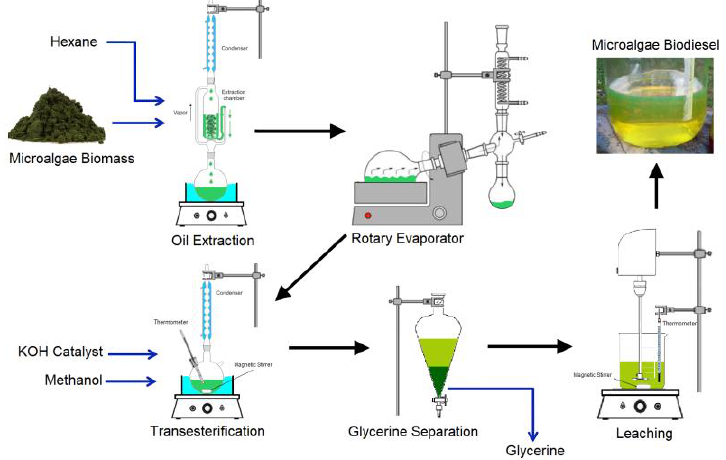
Fig. 2. Process description to produce microalgae